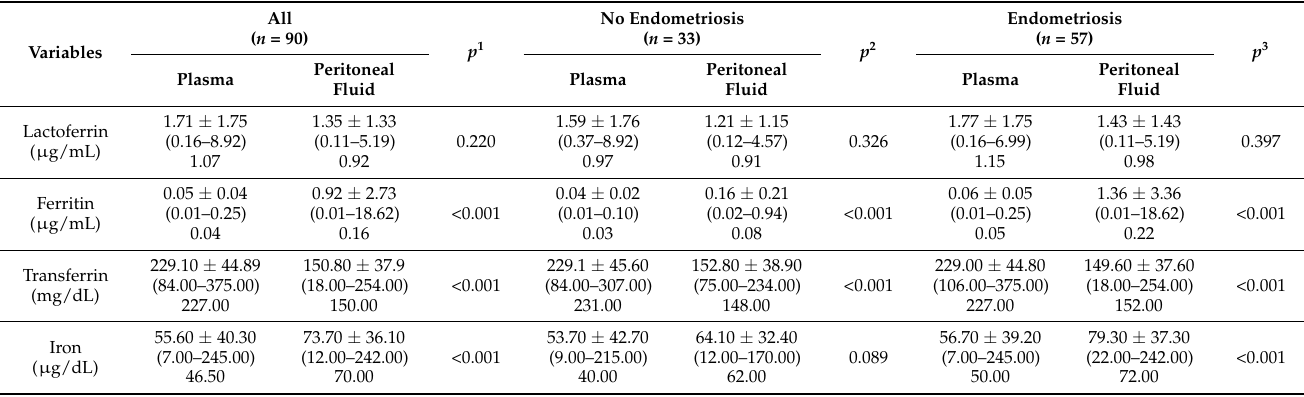
Table 2. Comparison of four variables between plasma and peritoneal fluid, regarding the presence of endometriosis.